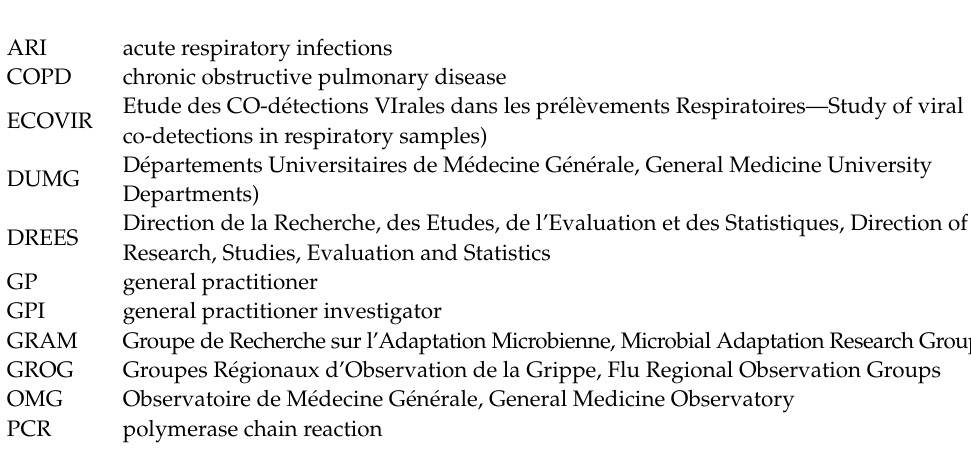
Study Status: The final protocol was submitted to the “East II” Protection Committee (study reference 18/10/10/63004) on 10 October 2018. The protocol package was transmitted to the committee